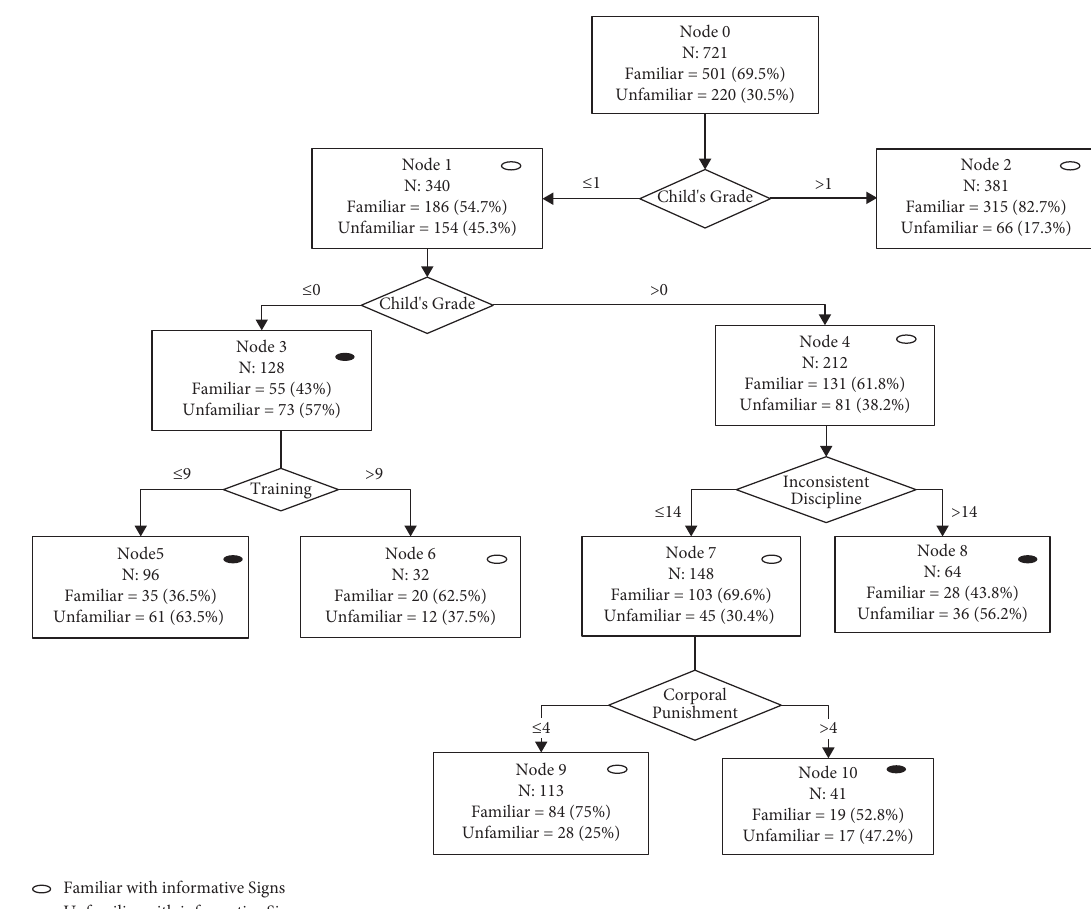
Figure 4: Decision tree of the informative sign model (training